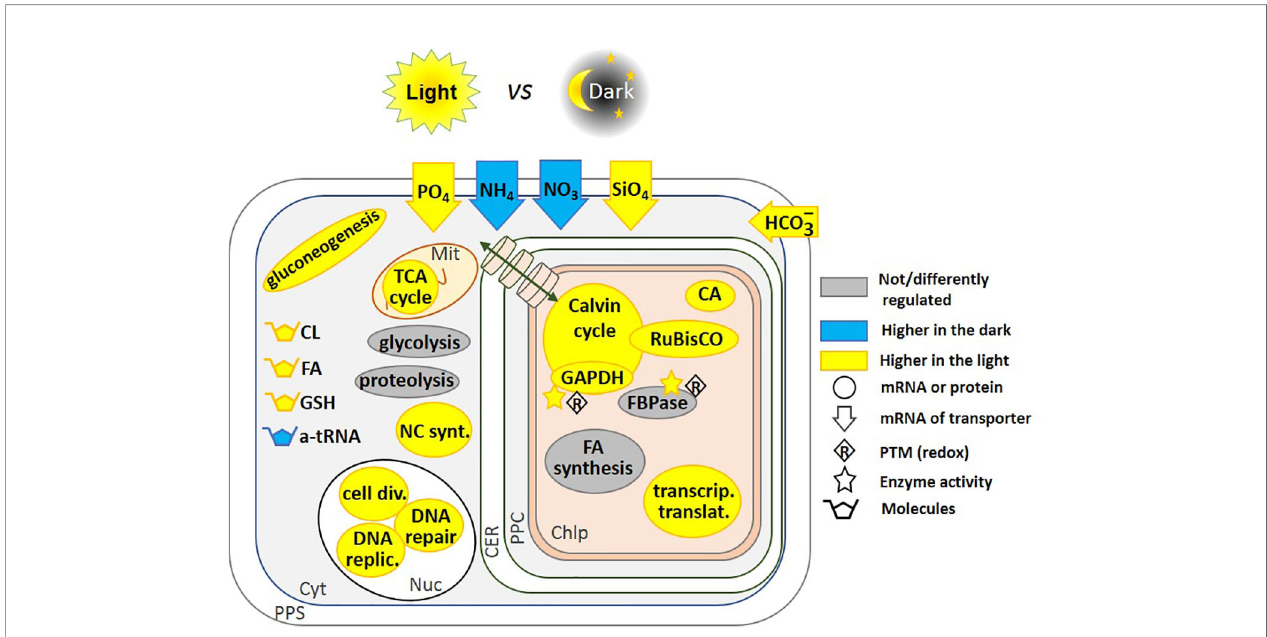
FIGURE 2 | Regulation of pathways by light and dark. This schematic includes regulatory pathways from P. tricornutum (Chauton et al., 2013; Bai et al., 2016), and T. pseudonana (Ashworth et al., 2013). Where up-regulation of the mRNA transcription preceded the start of the photoperiod, we have represented it as being higher in the light, this is the case for RuBisCO expression in T. pseudonana (Ashworth et al., 2013). Glycolysis and proteolysis pathways are up-regulated in the light in T. pseudonana , but down-regulated in P. tricornutum . In contrast, fatty acid synthesis is down-regulated in T. pseudonana but up-regulated in P. tricornutum . Fatty acid content increased after 3 h of light in P. tricornutum (Chauton et al., 2013), we have thus represented the molecule as being higher in the light. FBPase gene expression is not regulated, but its activity is redox-regulated (Michels et al., 2005; Mekhal fi et al., 2012). Redox regulation of enzyme activity has been shown on the isolated proteins in vitro , and by analogy with the Viridiplantae lineage, this could be related to light-to-dark transitions. The transport of molecules between the cytoplasm and the chloroplast is represented by a green double-headed arrow across cylinders. CL, Chrysolaminarin; FA, Fatty Acid; GSH, Glutathione; a-tRNA, aminoacyl-transfer RNA; CA, Carbonic Anhydrase; NC synt., Nucleotide synthesis; cell div., Cell division; DNA replic., DNA replication; PPS, Periplasmic Space; CER, Chloroplast Endoplasmic Reticulum; PPC, Periplastidial Compartment; Mit, Mitochondrion; Chlp, Chloroplast; Cyt, Cytoplasm; Nuc,